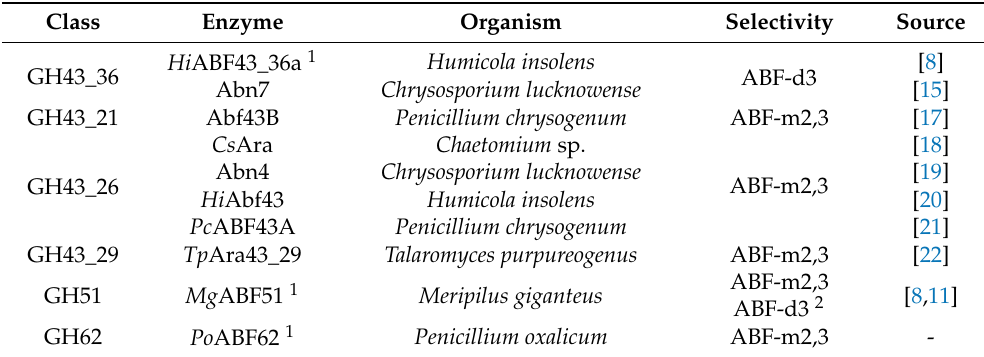
Table 1. List of characterized fungal GH43 ABFs described in literature and GH51 and GH62 used in this study plus their reported ABF